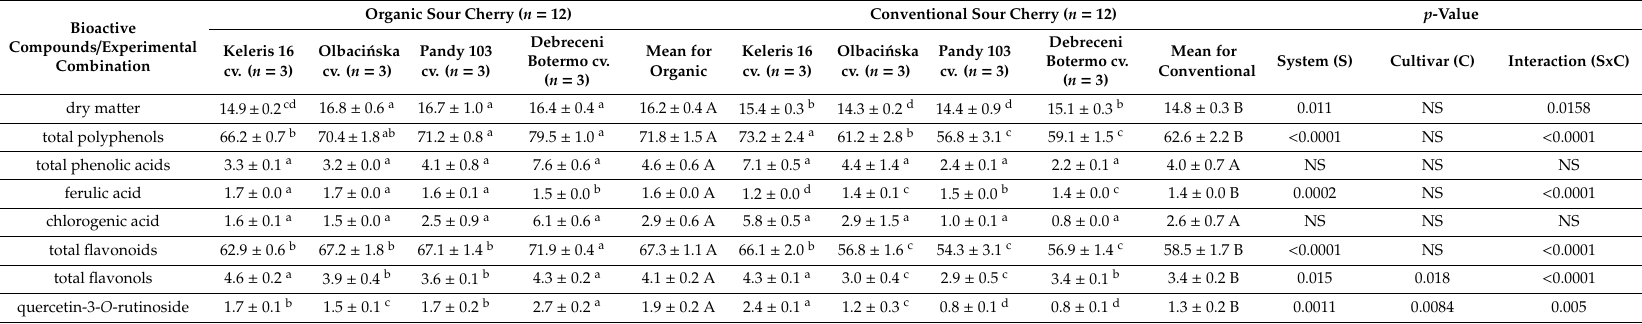
Table 2. The content of dry matter (in g / 100 g FW) and polyphenols (in mg / 100 g FW) in examined sour cherry cultivars in